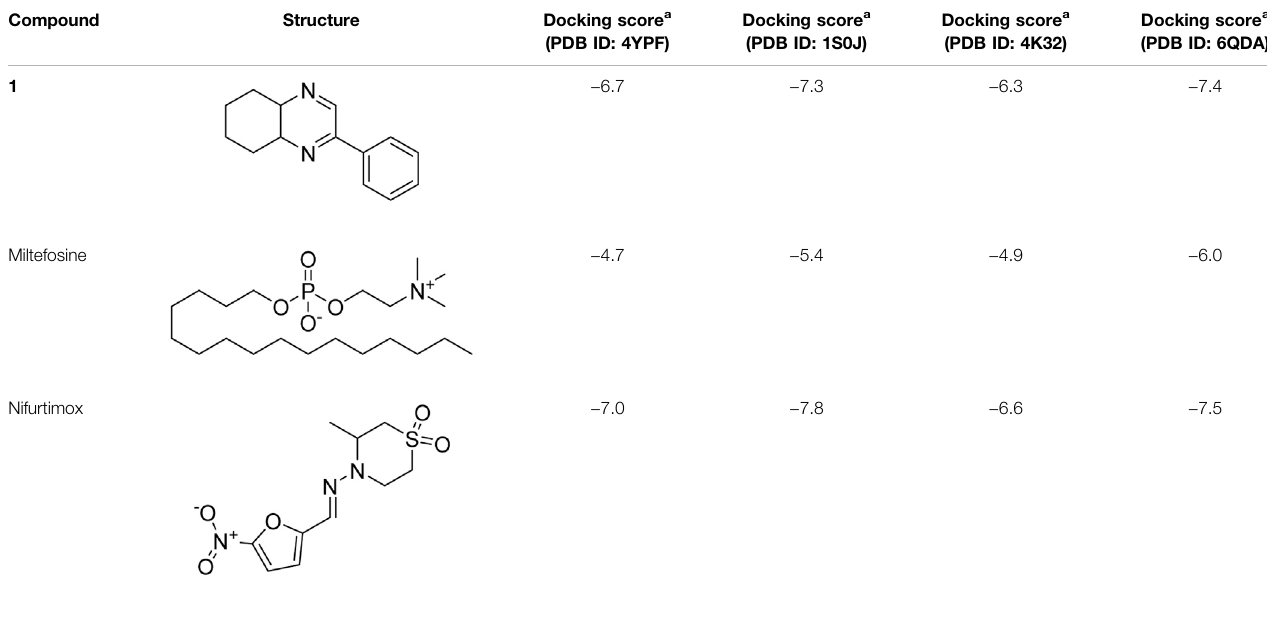
TABLE 3 | Molecular docking scores of the compound 1 and the standard controls with the biomolecular targets. Compound